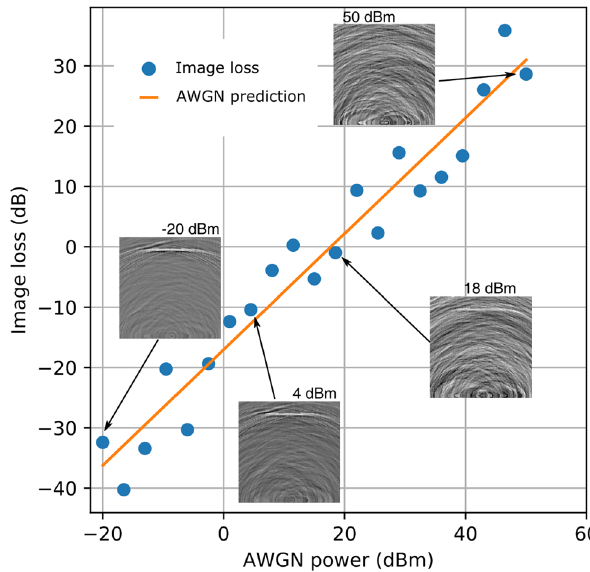
Fig. 5 Noise analysis of image reconstruction model. Image loss (blue dots) as a function of additive white Gaussian noise (AWGN) and the AWGN prediction (orange line). Insets show the recovered images at different noise levels for comparison.